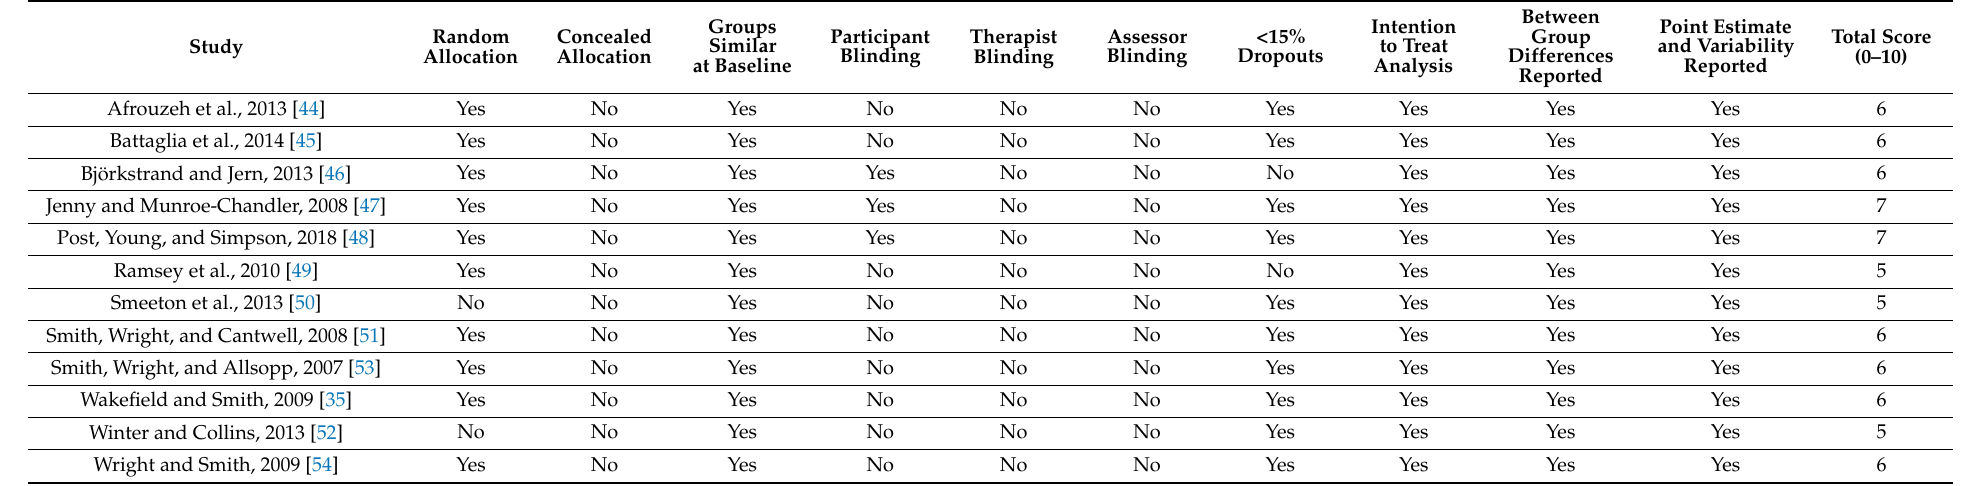
Table 2. PEDro scale scores for the selected